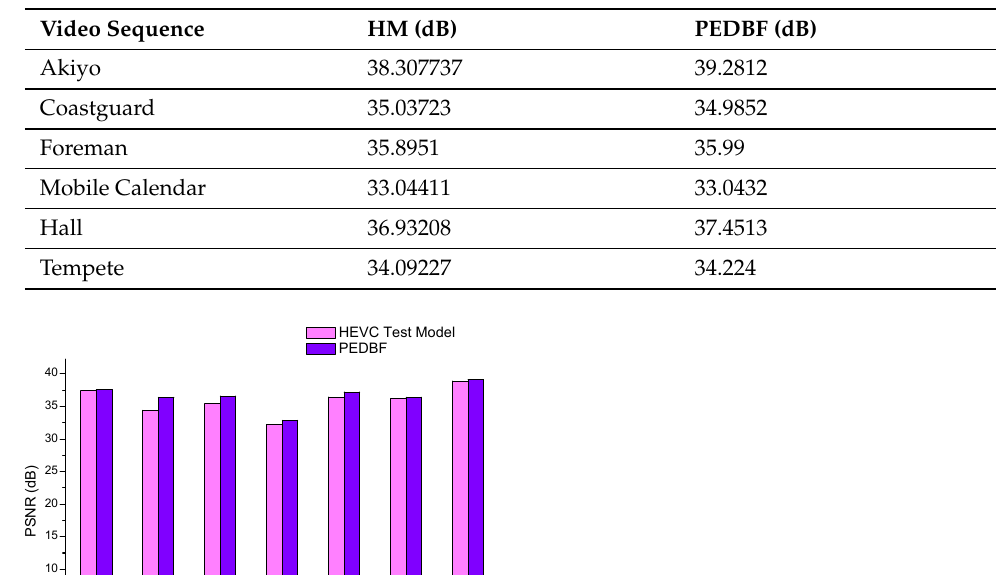
Table 2. PSNR of CIF video sequences with QP = 32.